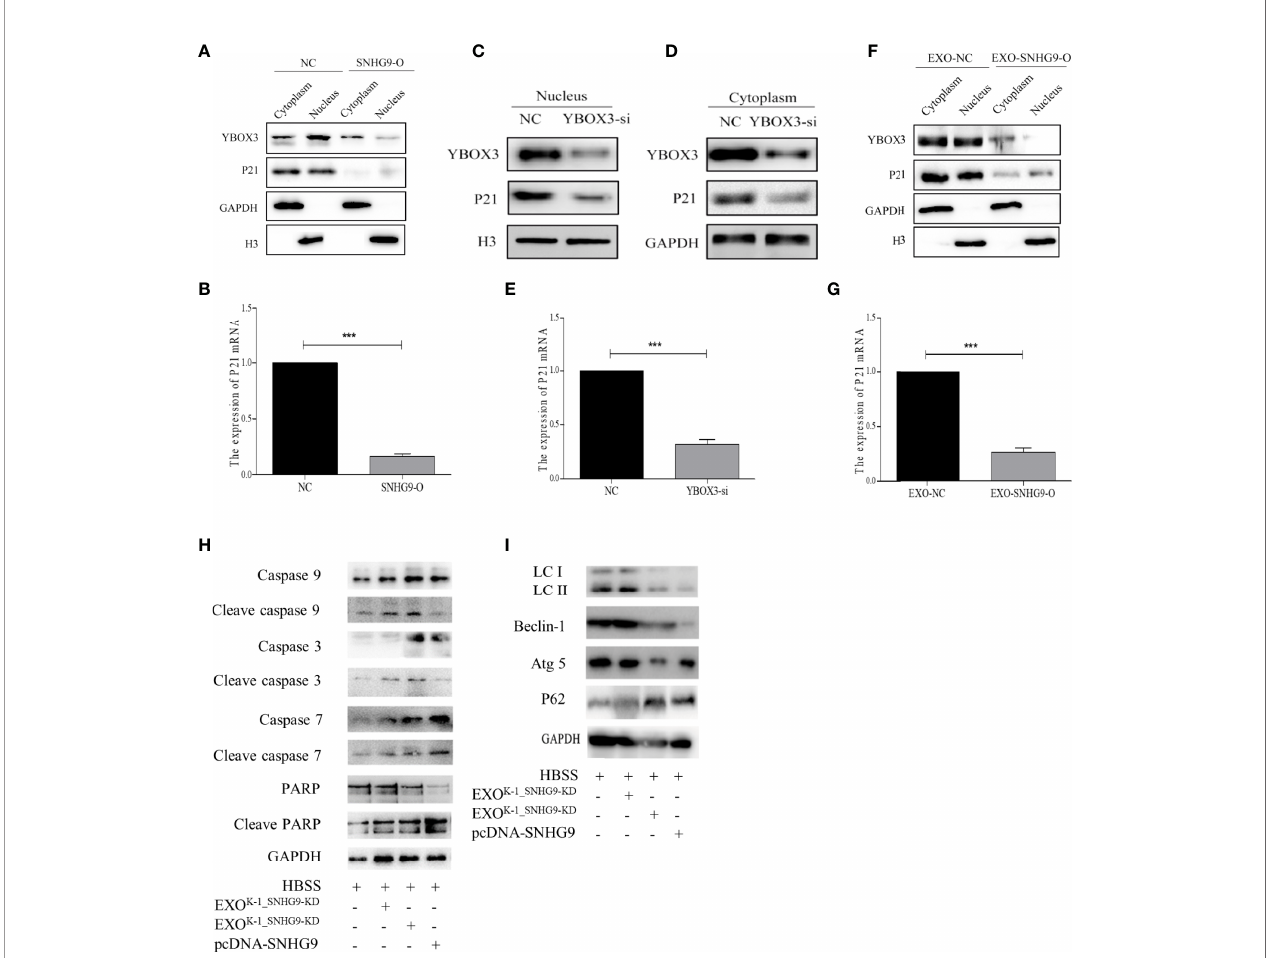
FIGURE 5 | SNHG9 interferes with YBOX3 and inhibits P21 expression through PTC exosomes and regulates Nthy-ori-3 cell autophagy and apoptosis. (A) SNHG9 overexpression could inhibit YBOX3 and P21 protein expression level in both the cytoplasm and nucleus tested by Western blotting. The intracellular reference was GAPDH. The internal nuclear reference was H3. (B) P21 mRNA expression was decreased by SNHG9 overexpression in Nthy-ori-3 cell tested by qPCR. (C, D) Both P21 and YBOX3 protein expression were downregulated in cytoplasm and nucleus of Nthy-ori-3 cell after transfection of small interfering RNA for YBOX3. (E) P21 mRNA expression was decreased in Nthy-ori-3 cell after transfection of small interfering RNA for YBOX3. (F) Both P21 and YBOX3 protein expression were downregulated in cytoplasm and nucleus of Nthy-ori-3 treated with exosomes of K-1_SNHG9-O. (G) P21 mRNA expression was decreased in Nthy-ori-3 cell treated with exosomes of K-1_SNHG9-O. (H) Apoptosis pathway related protein expression in Nthy-ori-3 cells overexpressing SNHG9 or treated with K-1_SNHG9-O. (I) Autophagy pathway related protein expression in Nthy-ori-3 cells overexpressing SNHG9 or treated with K-1_SNHG9-O. ***P < 0.001, data were pooled from three independent experiments. PTC, papillary thyroid cancer; O, overexpression; qPCR, quantitative polymerase chain